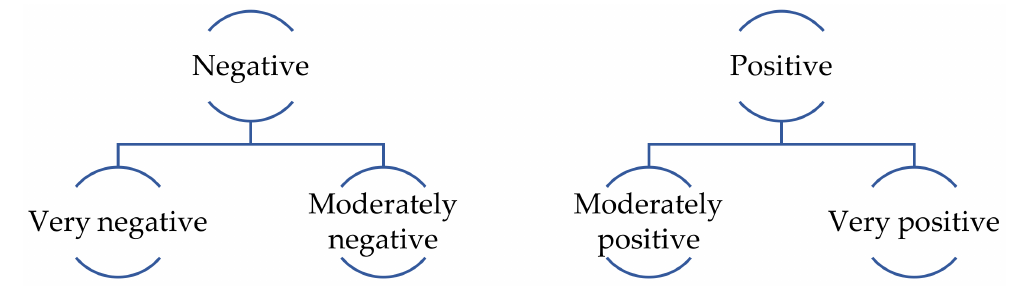
Figure 2. System for sentiment